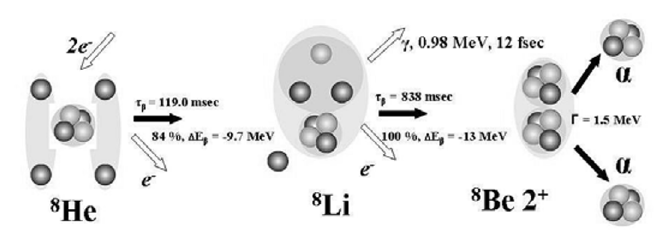
Figure 1. Scheme of a major channel of the cascade decay of 8 He isotope; light circles correspond to protons, dark ones – neutrons.